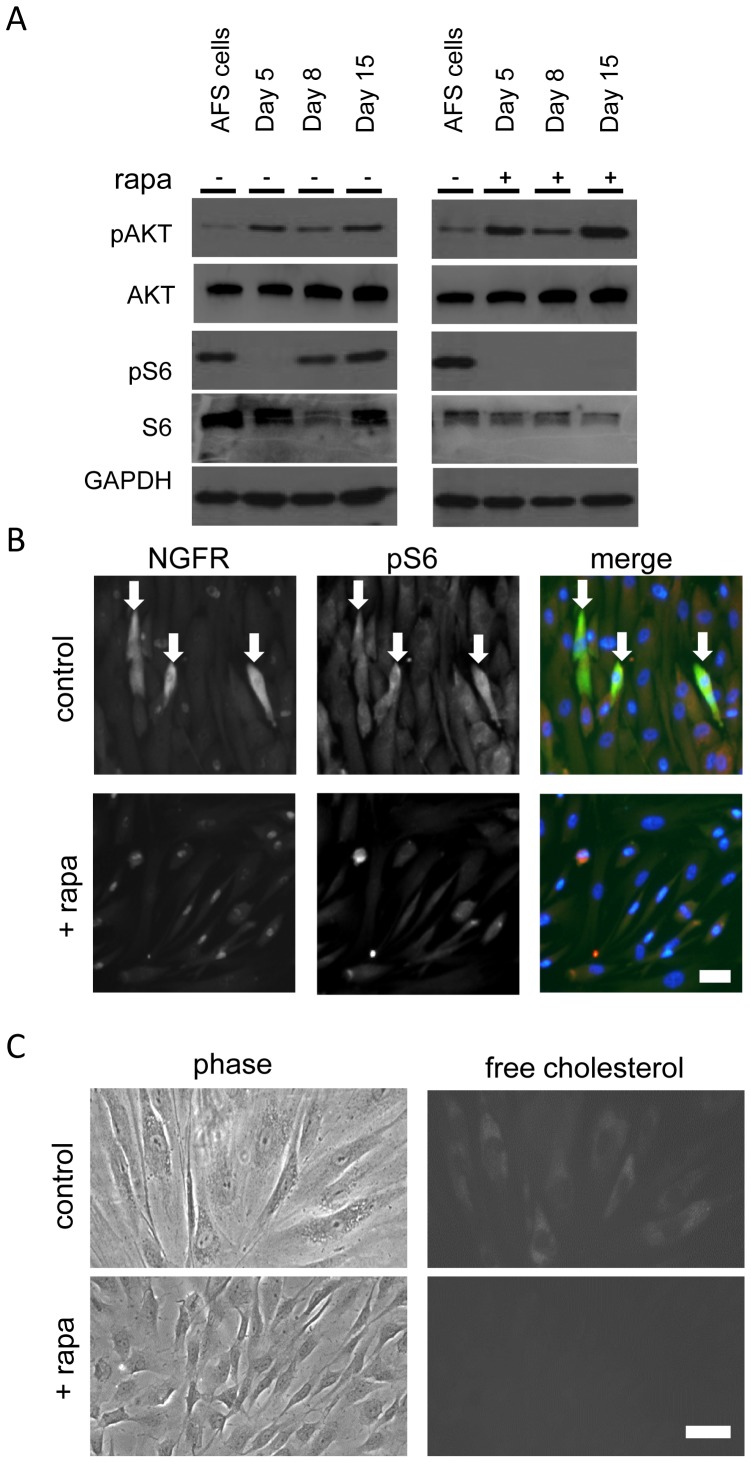
mTOR signaling is active in differentiated AFS cells and important for the differentiation process.(A) AKT phosphorylation at Ser 473 and ribosomal protein S6 phosphorylation at Ser 240/244 were quantified at the indicated time points during differentiation with and without rapamycin treatment. (B) NGFR, a marker for early differentiated AFS cells (labeled in green), was co-stained with phosphorylated S6 at Ser 240/244 protein (labeled in red) with and without rapamycin treatment (nuclei labeled in blue). Scale bar represents 10 µm. (C) Accumulation of free cholesterol was monitored by filipin III staining. Scale bar represents 10 µm.